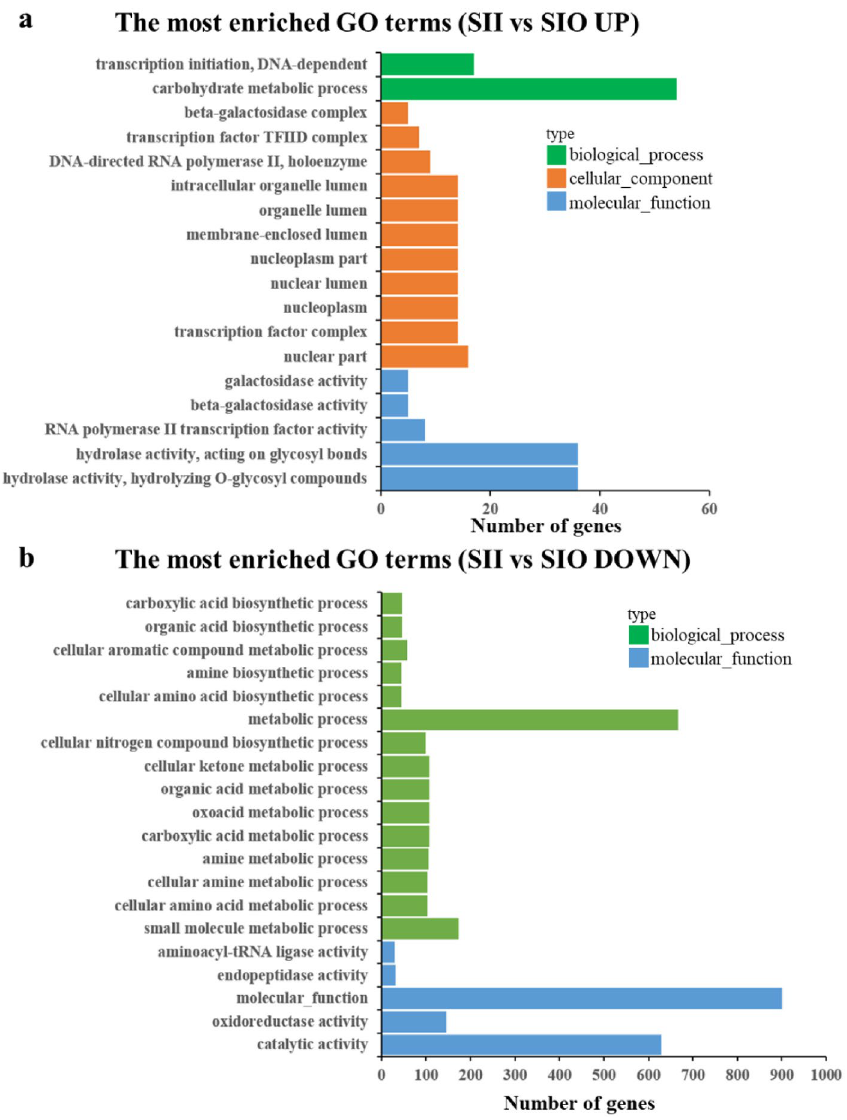
Figure 3. The most enriched GO terms of up and down DEGs compared between SII and SIO. All 18 in up and the top 20 (ranked with P value) GO terms in down were